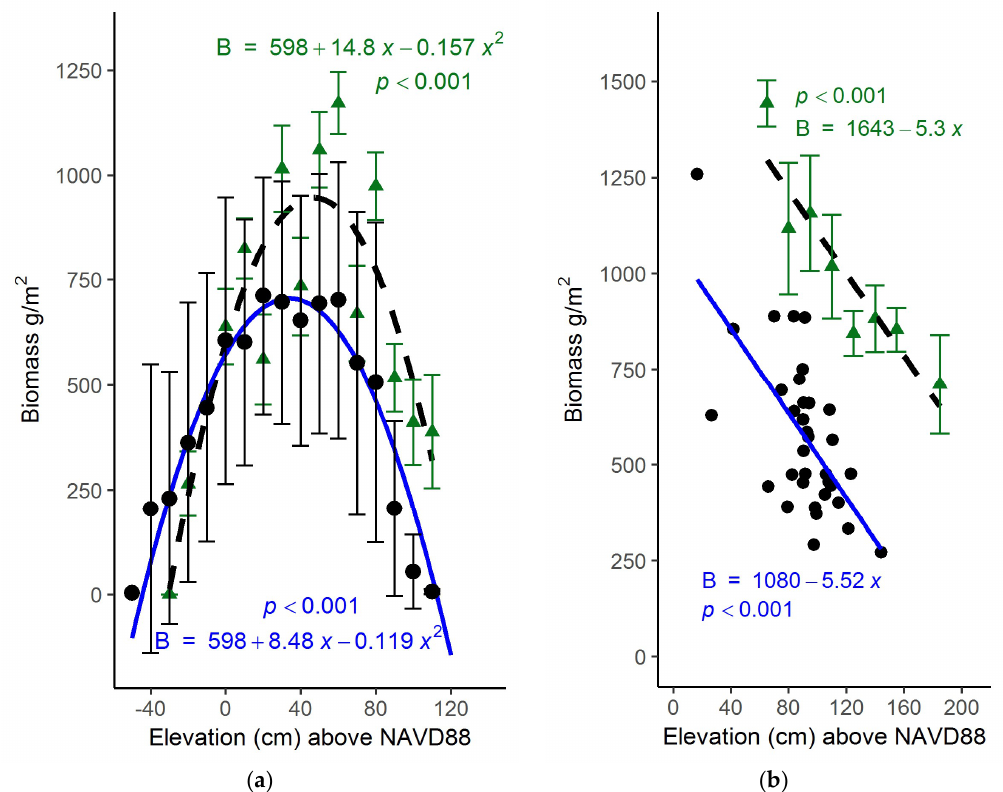
Figure 5. Aboveground biomass (g/m 2 ) versus plot elevation (cm) above NAVD88 within North Inlet and PIE. ( a ) North Inlet—shown in black are the means (±1 SD) of calculated biomass found at North Inlet across a range of elevations modelled using Equation (2). Biomass predictions shown here were back-transformed by squaring the model calculation. The blue line is a least-squares fit of a parabola ( p < 0.001) to these data. Shown in green are the means (±1 SE) from a North Inlet marsh-organ experiment [9] and the least-squares best fit of a parabola. ( b ) PIE—black circles are (June) harvested biomass samples from this study collected in salt marshes dominated by Spartina alterniflora . The blue regression line indicates dependence of field collected biomass (g/m 2 ) on elevation (cm). Green triangles are means (±1 SE) of end-of-season biomass from in PIE marsh organ experiment [9] with dashed linear regression line.